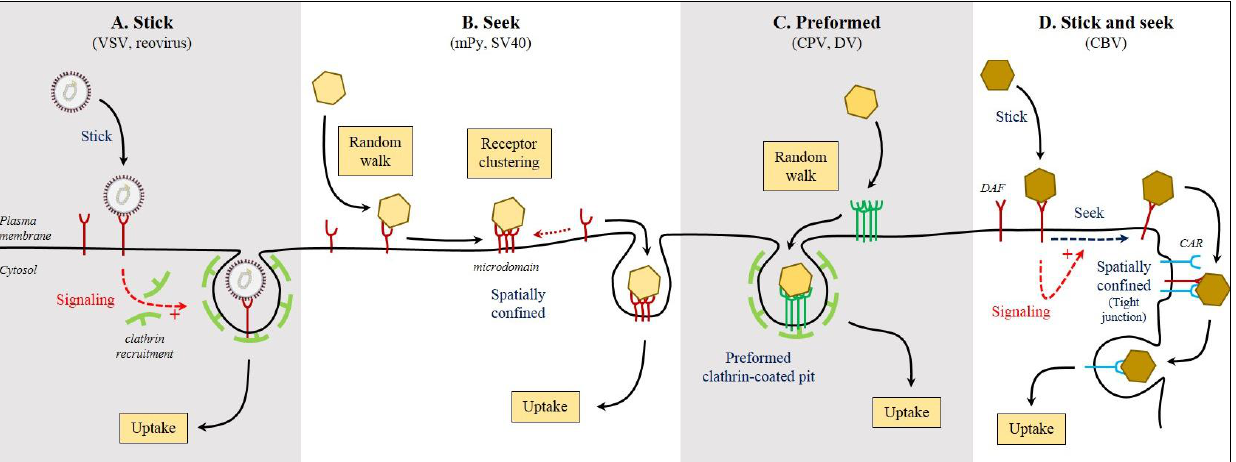
Figure 2. How viruses find their receptor(s). Viruses have evolved different strategies to interact with their receptor(s) at the surface of host cells. ( A ) After landing on the cell surface and binding to receptor(s), some viruses remain stick at a confined location from where they will be endocytosed in a passive or signal-induced manner; ( B ) Others, after binding to their receptor, will diffuse at the cell surface seeking additional receptor molecules. The virus/receptor complex will be then spatially confined in a host plasma membrane microdomain from where it will be endocytosed; ( C ) Some viruses, following binding to their receptors, diffuse at the surface of the host cell seeking for preformed endocytic structures that they hijack to mediate their internalization; ( D ) Viruses can land on the surface of the cells and bind to a primary receptor. This initial binding induces signaling that leads to active redistribution of the virus/primary receptor complex seeking for a secondary receptor that mediates virus uptake. Abbreviations : CAR, coxsackievirus and adenovirus receptor; CBV, group B coxsackievirus; CPV, canine parvovirus; DAF, CBV co-receptor; DV, dengue virus; mPy, mouse Polyomavirus; SV40, simian polyomavirus 40; VSV, vesicular stomatitis virus.